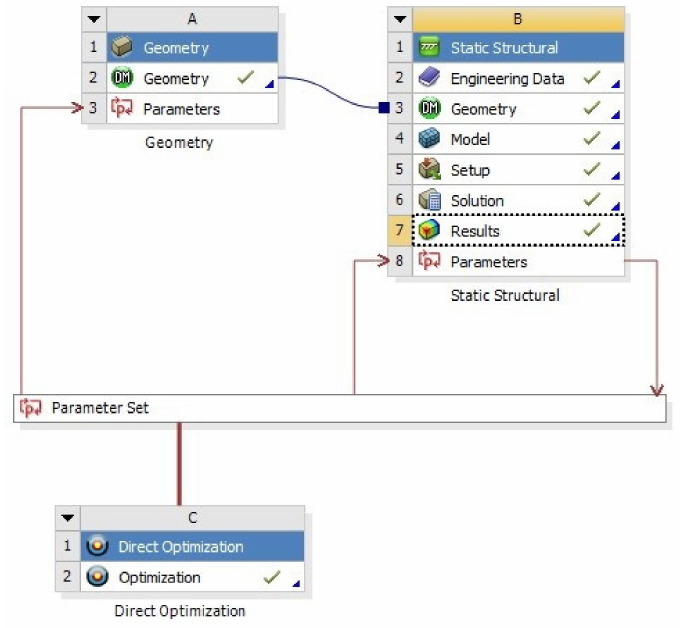
Figure 15. Direct optimization flow chart.